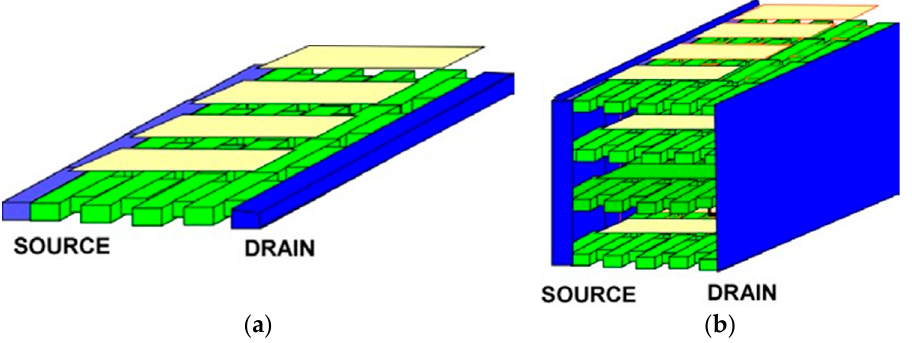
Figure 7. 2D ( a ) and 3D ( b ) plasmonic crystals of variable width.